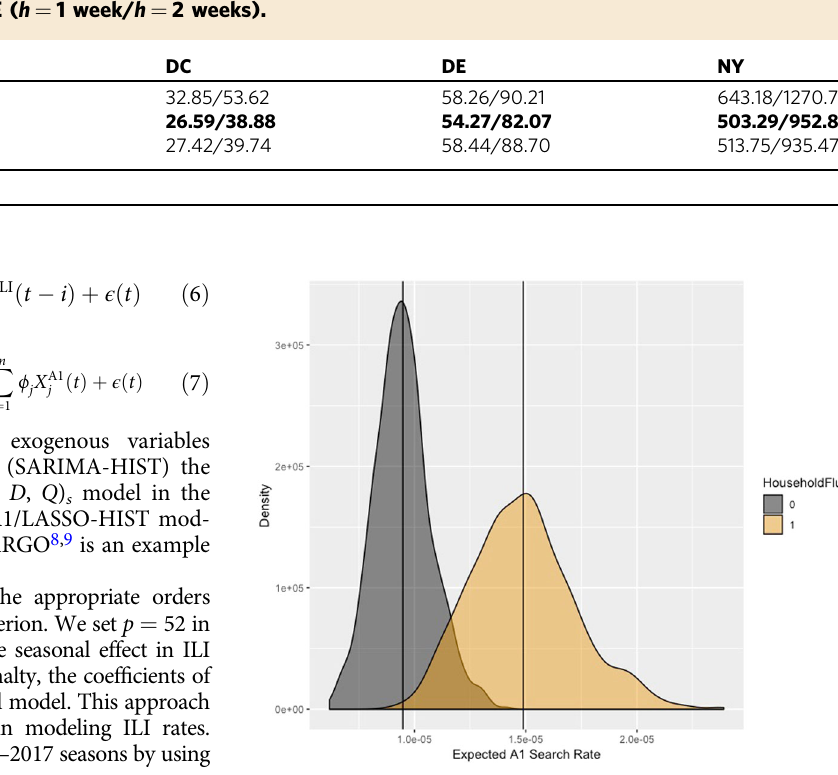
Fig. 1 Estimated search rates by fl u presence. Estimated population-level search rates. Based on survey data in the presence of reported household fl u (in light yellow) and absence of reported household fl u (in dark grey). The x -axis indicates a proportion of searches and the y -axis indicates the estimated density of searches where household fl u = 0,